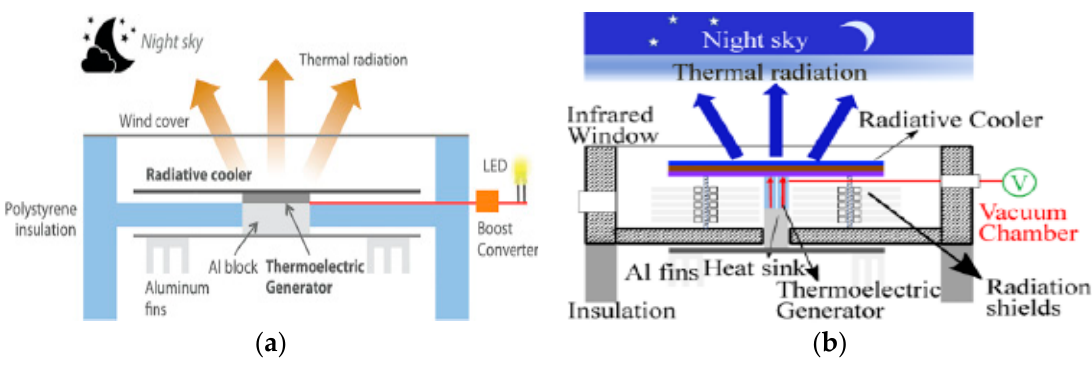
Figure 41. ( a ) Configuration of the main parts of the economical TE generator for the night [187] and ( b ) system design for optimal nighttime power generation [188].